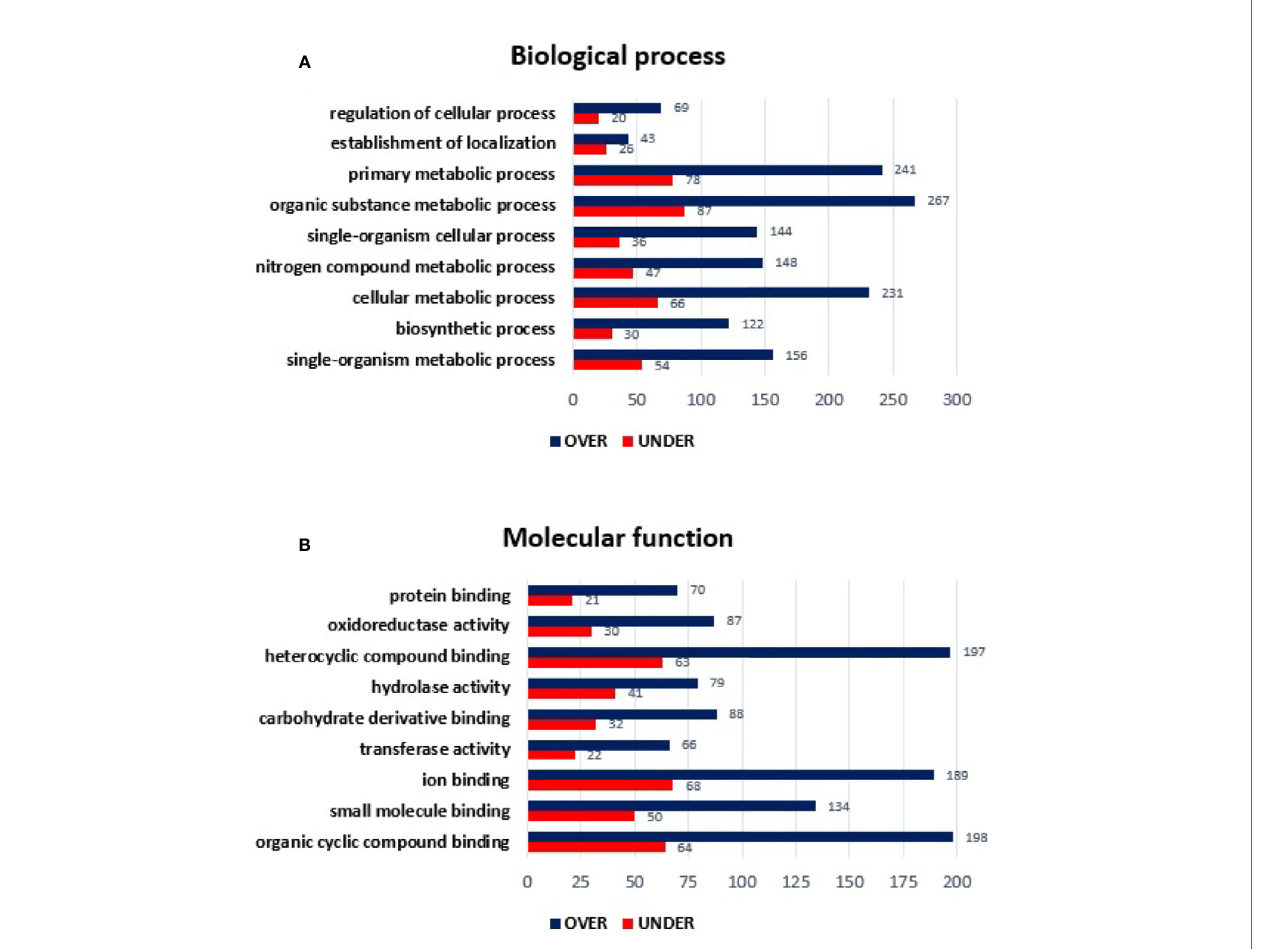
FIGURE 3 | Gene ontology of differentially represented proteins from midgut of R. sanguineus tropical lineage vs. R. sanguineus temperate lineage in the non- infection condition. GO terms and its representation of biological process (A) , and molecular function (B) obtained using level 3. Blue bars represent the number of over-represented proteins in the tropical lineage compared to the temperate lineage and red bars represented the number of under-represented proteins in the tropical lineage compared to the temperate lineage (can be interpreted as the number of proteins more represented in the temperate lineage compared to the tropical lineage), with statistical signi fi cance ( p <